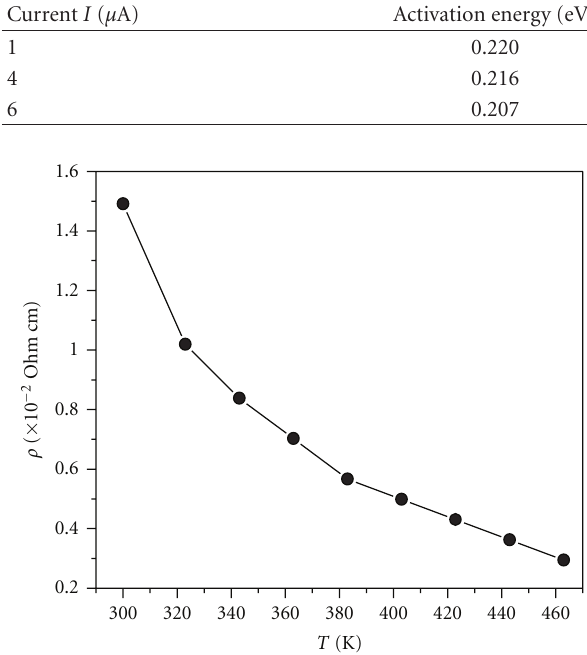
Figure 3: Variation of resistivity with temperature.